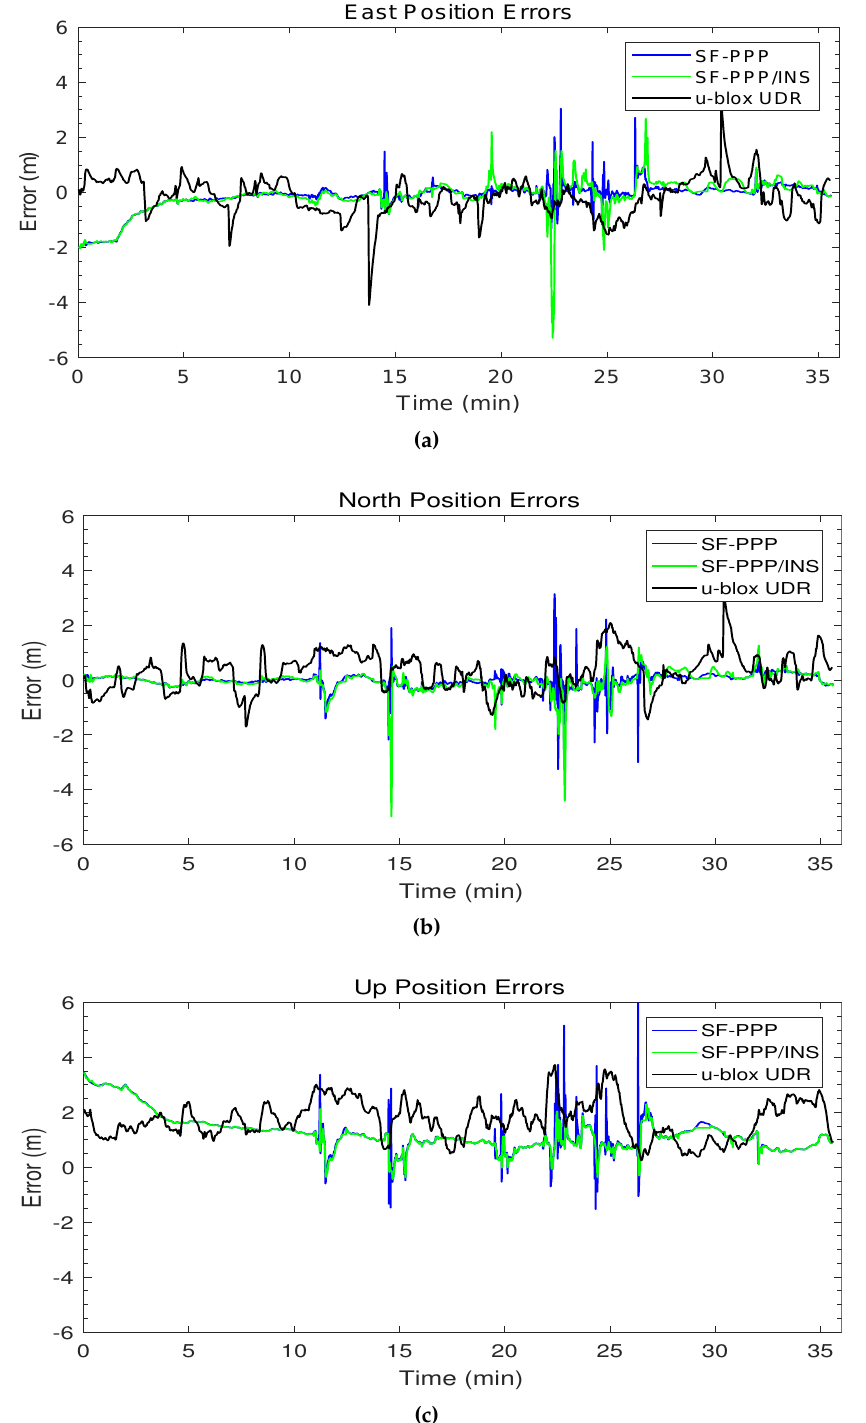
Figure 6. The first trajectory position errors versus time in ( a ) east, ( b ) north, and ( c ) up directions. Table 1 compares the RMS and maximum errors of both u-blox UDR and the developed SF-PPP/INS solutions after the first 5 min to avoid the initial convergence time without ionospheric corrections. The developed SF-PPP/INS system achieved sub-meter RMS horizontal accuracy, and the results were better than the u-blox UDR solution. Furthermore, the RMS error in the vertical direction of the developed system is less than the UDR solution. This error reduction indicates that the integrated solution has benefited from the SF-PPP precise solution in the case of benign GNSS